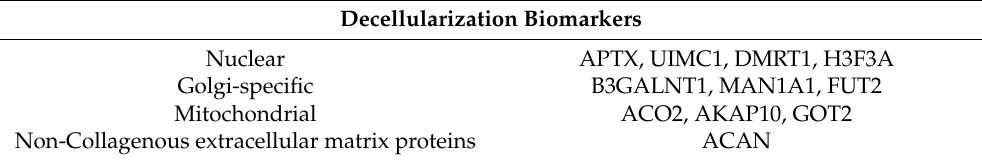
Table 2. Different decellularization biomarkers in the